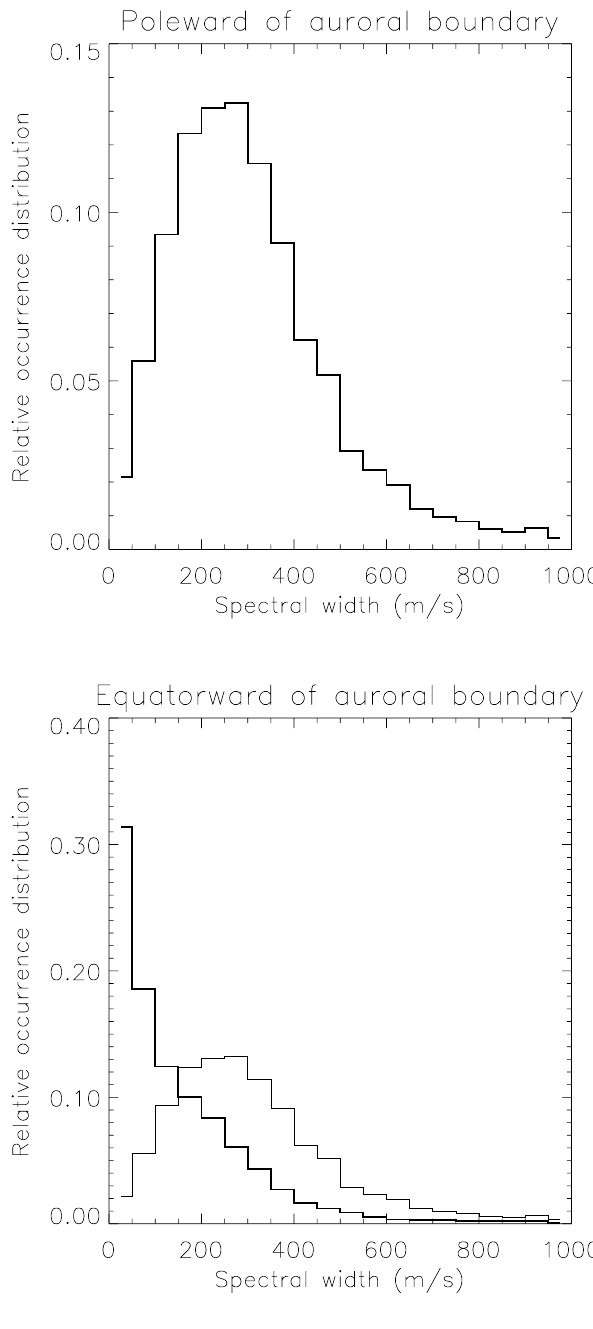
Fig. 6. Occurrence histograms of spectral width poleward of the 1.5 kR contour (upper panel) and equatorward of the 1.5 kR contour (lower panel, thick line). Note the distribution from the upper panel is overlaid in the lower panel as a thin